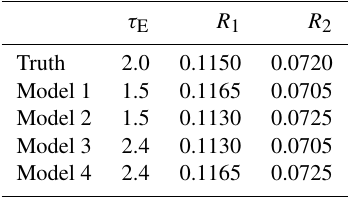
Table 5. Parameter values of the imperfect QG models. Table 6. Weights of the imperfect QG models at 200, 500 and